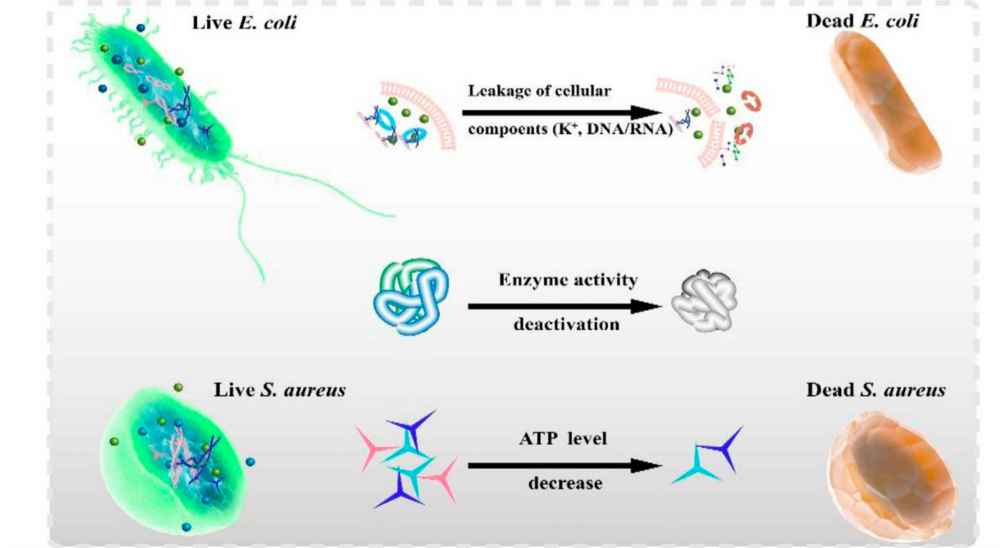
Figure 1. Hyperthermia effects on the antibacteria via changing cell membrane permeability, enzyme inactivation, and protein denaturation [95]. Copyright 2021,